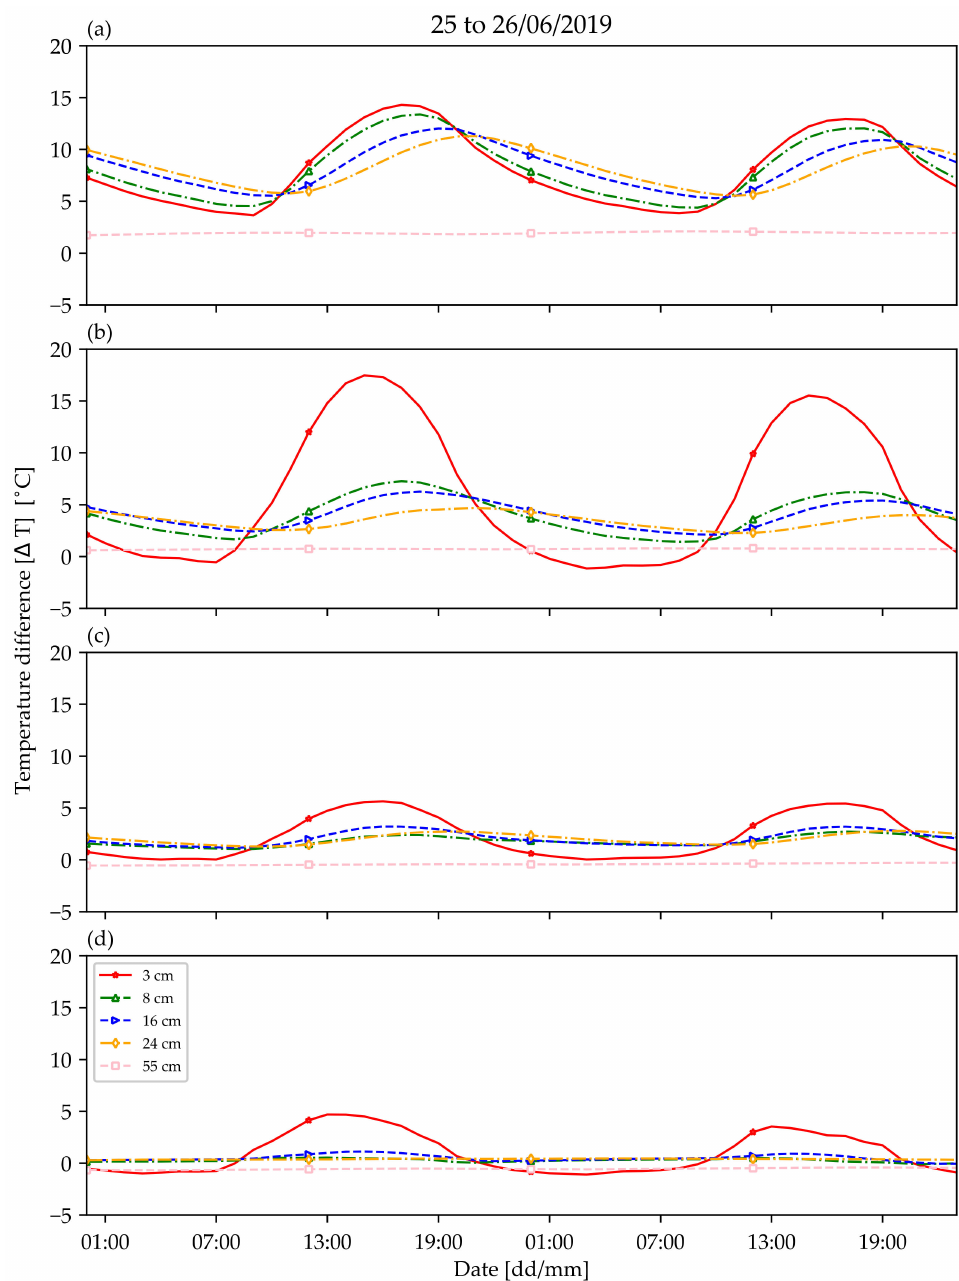
Figure 12. Representation of the temperature difference ∆ T ( ◦ C) based on Equation (1) at the different depths for the P1 ( a ), P3 ( b ), P4 ( c ), and P5 ( d ) systems compared to the control area (CZ9) from 25 June–26 June 2019. Temperature at − 3 cm depth is represented with a red solid line with star markers. Temperature at − 8 cm depth is represented with a green dotted line with triangle up markers. Temperature at − 16 cm depth is represented with a blue dotted line with triangle right markers. Temperature at − 24 cm depth is represented with an orange dotted line with diamond markers. Temperature at − 55 cm depth is represented with a pink dashed line with square